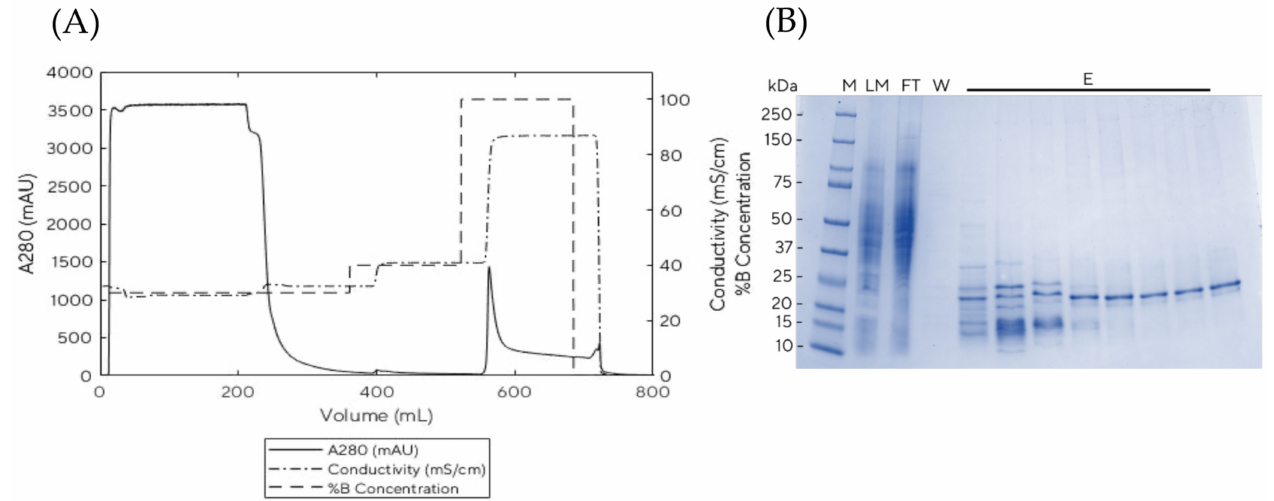
Figure 4. HiScale SP Sepharose Fast Flow Chromatogram ( A ) and SDS-PAGE analysis ( B ) of PCV2d purification. M = marker, IB = inclusion body, LM = loading material, FT = flow through, W= wash and E =